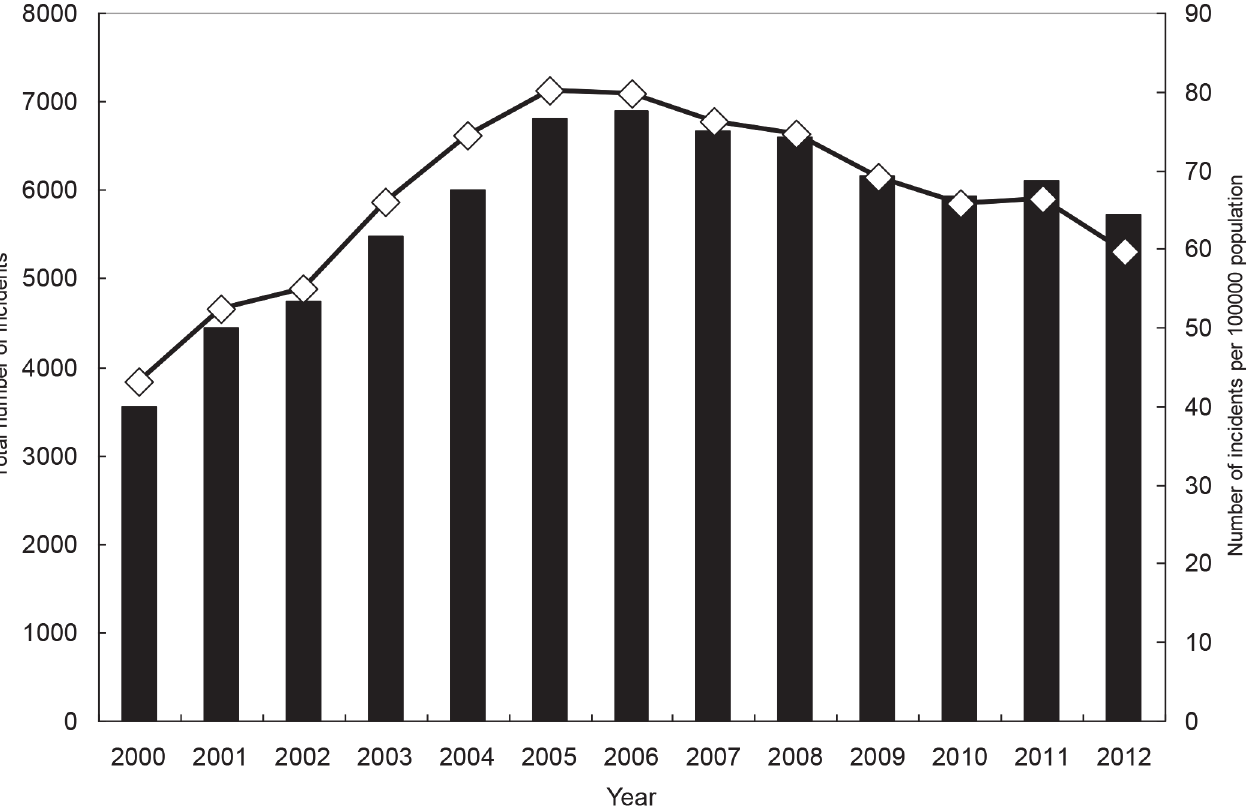
Fig 4. Total numbers of incidents with out-of-hospital cardiac arrest and incident rates, for